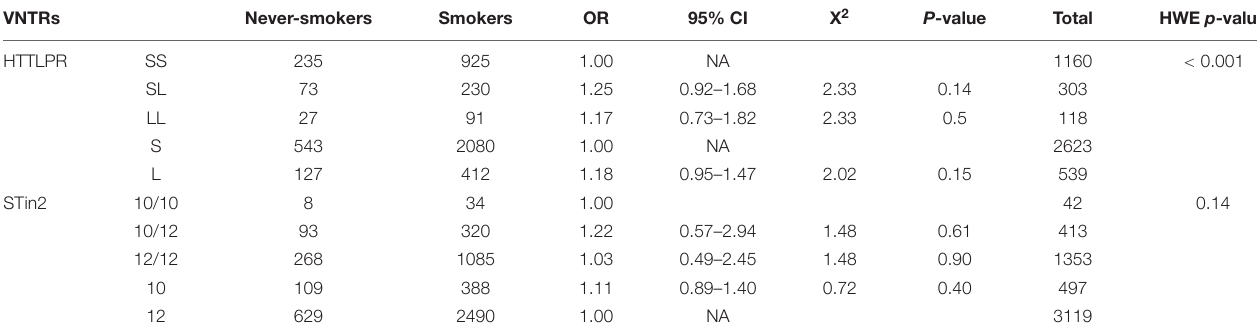
TABLE 1 | Results of the genotyping of two VNTRs in the SL6A4 gene, HTTLPR and STin2. VNTRs Never-smokers Smokers OR 95% CI X 2 P -value Total HWE p -value HTTLPR